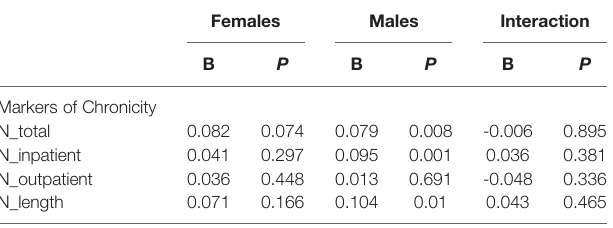
TABLE 3 | Association of GRPS With Chronicity by Sex (PT=0.05). Females